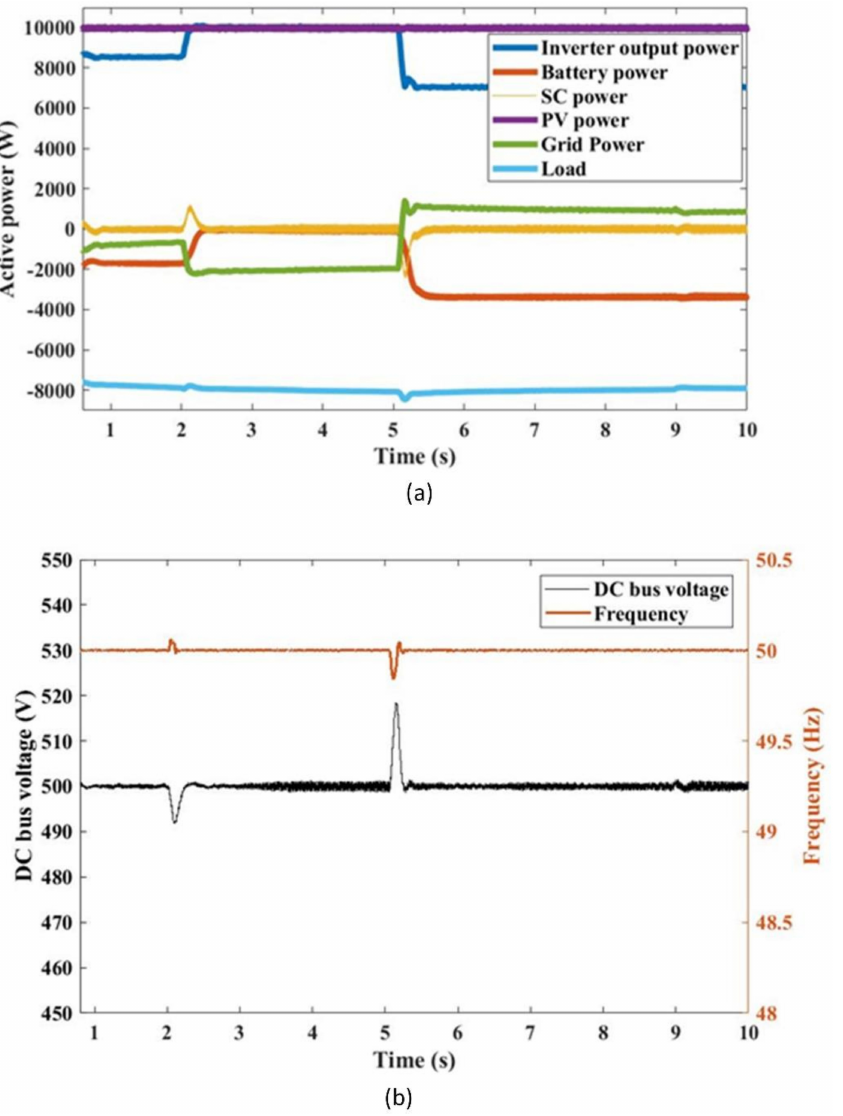
Figure 14. Real power under grid command variations; ( a ) Active power ( b ) DC bus voltage and